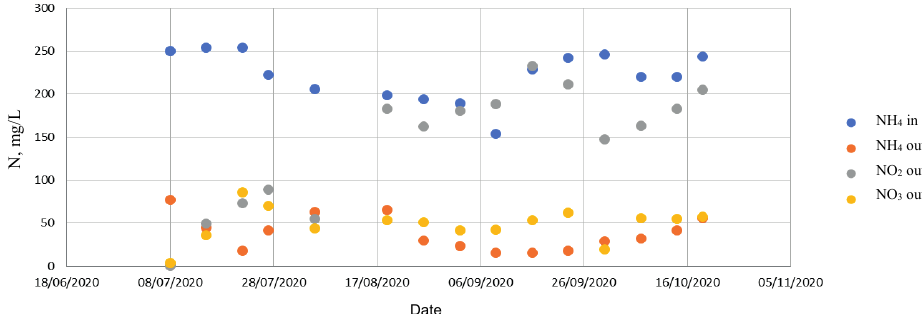
Fig. 3. Concentrations of ammonia nitrogen in the influent and of the different nitrogen forms (ammonia, nitrite and nitrate) in the effluent of the raceway pilot plant during the experimental period. In some cases, higher concentrations of total nitrogen were observed in the edffluent than in the influent; this difference could be due to water evaporation from the pond surface and to ammonia nitrogen release from the centrate TSS by hydrolysis and ammonification.